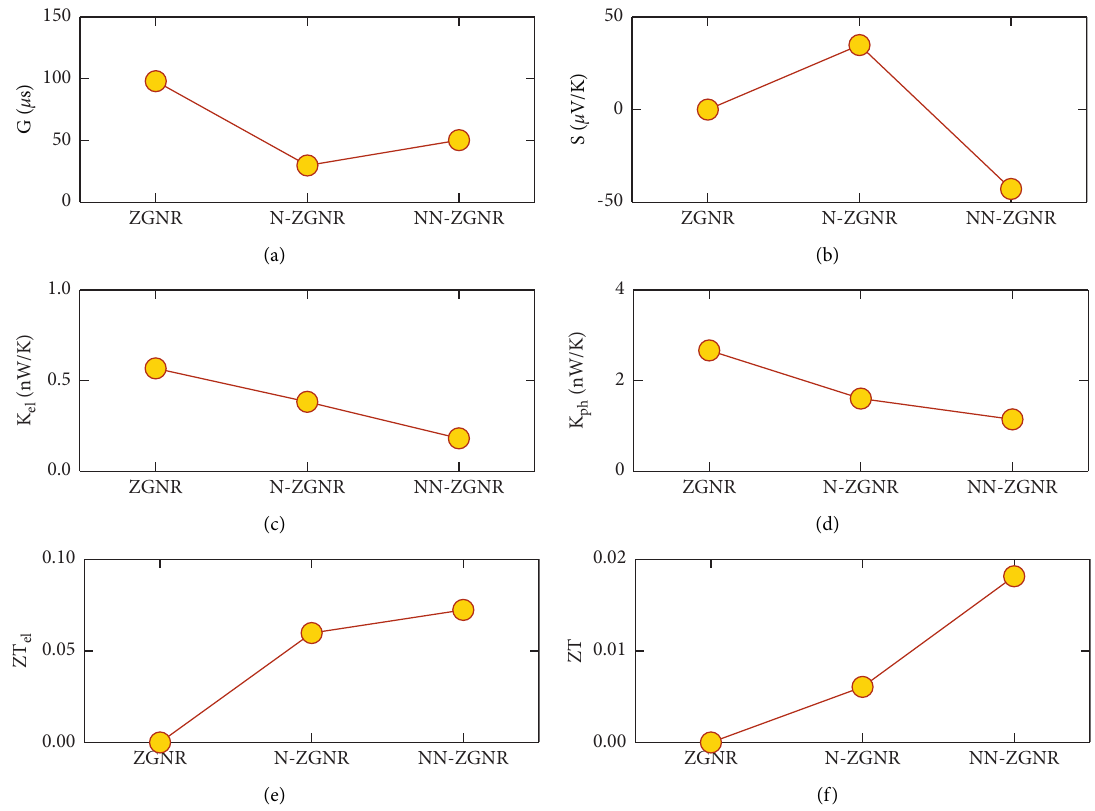
Figure 6: Comparative representation of thermoelectric coefficients for different configurations of the ZGNR system evaluated at T � 300 K. Electrical conductance (a), thermopower (b), electron contribution to the thermal conductance (c), phonon contribution to the thermal conductance (d), electronic figure of merit (e), and total figure of merit (f) calculated for the ZGNR, N-ZGNR, and NN-ZGNR